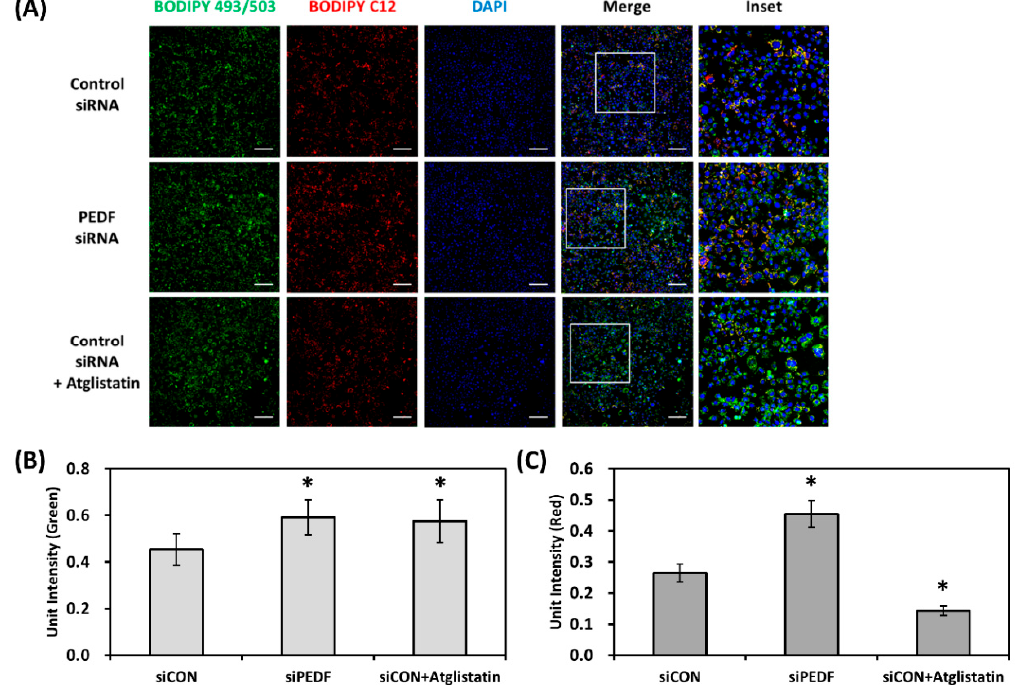
Figure 3. Knocking down PEDF increases hepatic fatty acid mobilization. ( A ) Magnification: 100x. Hep3B cells were transfected with control or PEDF siRNA before incubation with BODIPY 558/568 (1 µ M) for 6 h, followed by OA (0.1 mM) or OA + Atglistatin (25 µ M) treatment for 16 h. Lipid droplets C12 (1 μ M) for 6 h, followed by OA (0.1 mM) or OA + Atglistatin (25 μ M) treatment for 16 h. Lipid were stained with BODIPY 493 / 503 and nuclei were stained with DAPI. Scale bar: 200 µ m. ( B ) Lipid droplets were stained with BODIPY 493/503 and nuclei were stained with DAPI. Scale bar: 200 μ m. droplet accumulation was calculated by quantification of the BODIPY 493 / 503 fluorescent ( B ) Lipid droplet accumulation was calculated by quantification of the BODIPY 493/503 fluorescent intensity normalized to the cell number. ( C ) Mobilization of fatty acids was calculated by quantification of red signal intensity of the merged images, divided by the cell number. *, Statistically significant compared with the control transfected group at p < 0.05.